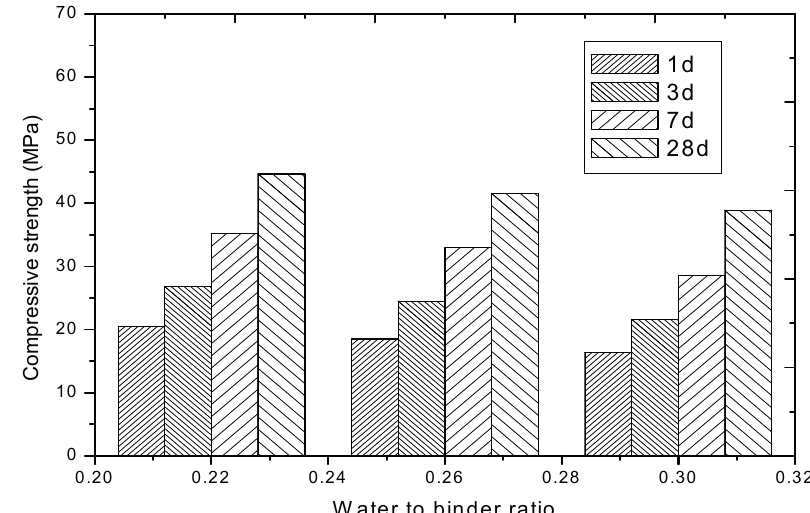
Figure 5. Compressive strength of MPC